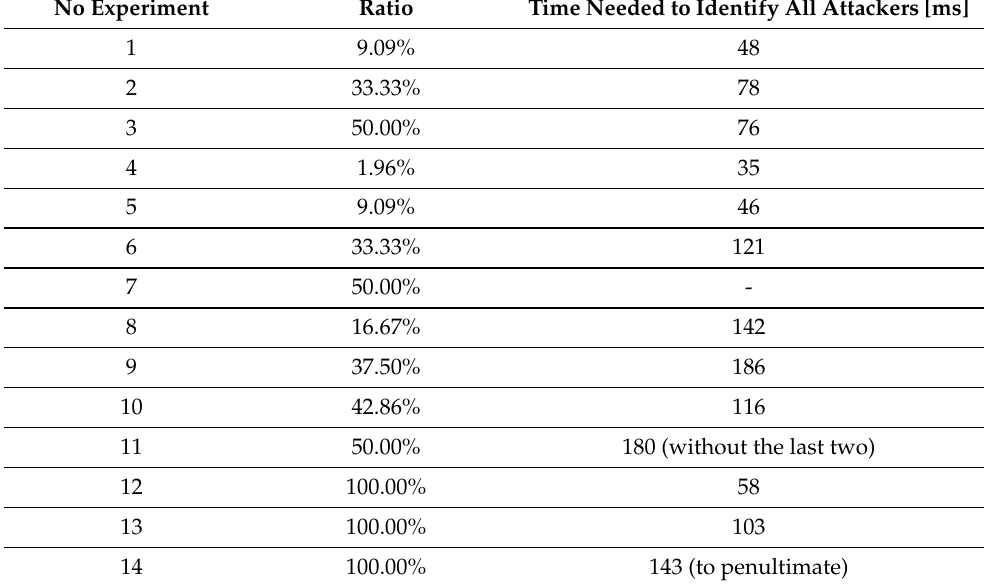
Table 5. Bogus & Sybil Trust Level & Timestamp algorithm—time needed to identify all attackers in